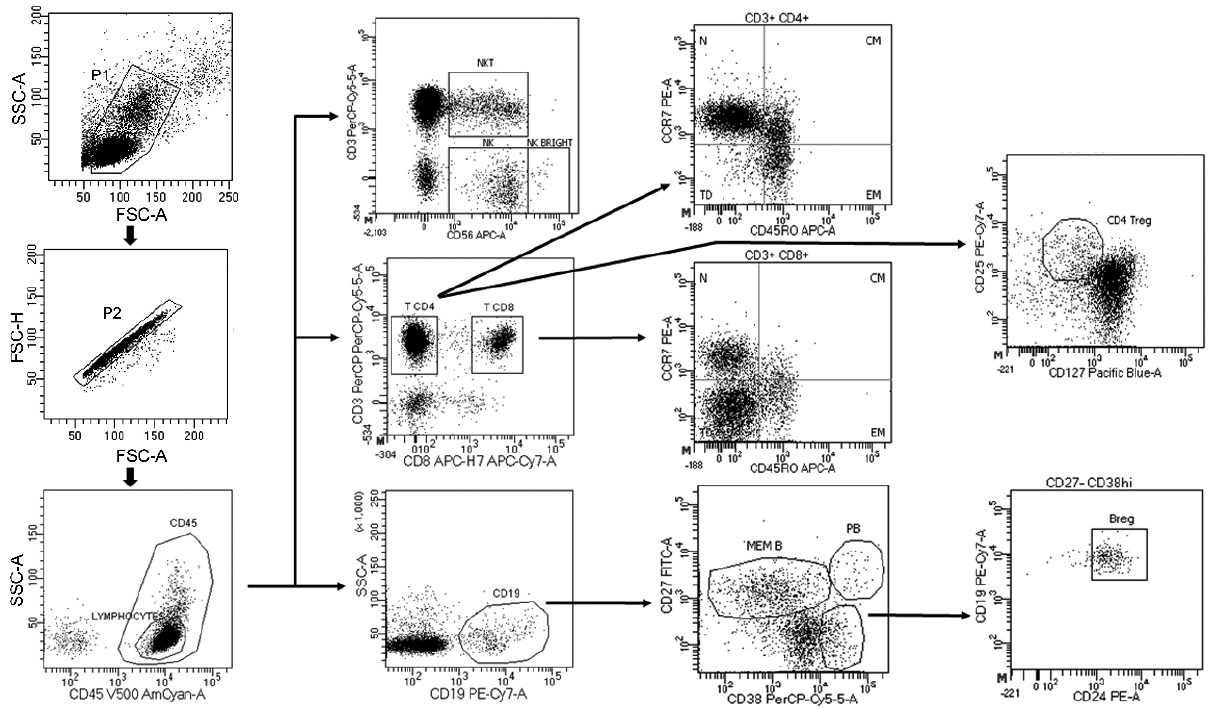
Figure 1. Gating Figure 1. Gating strategy.